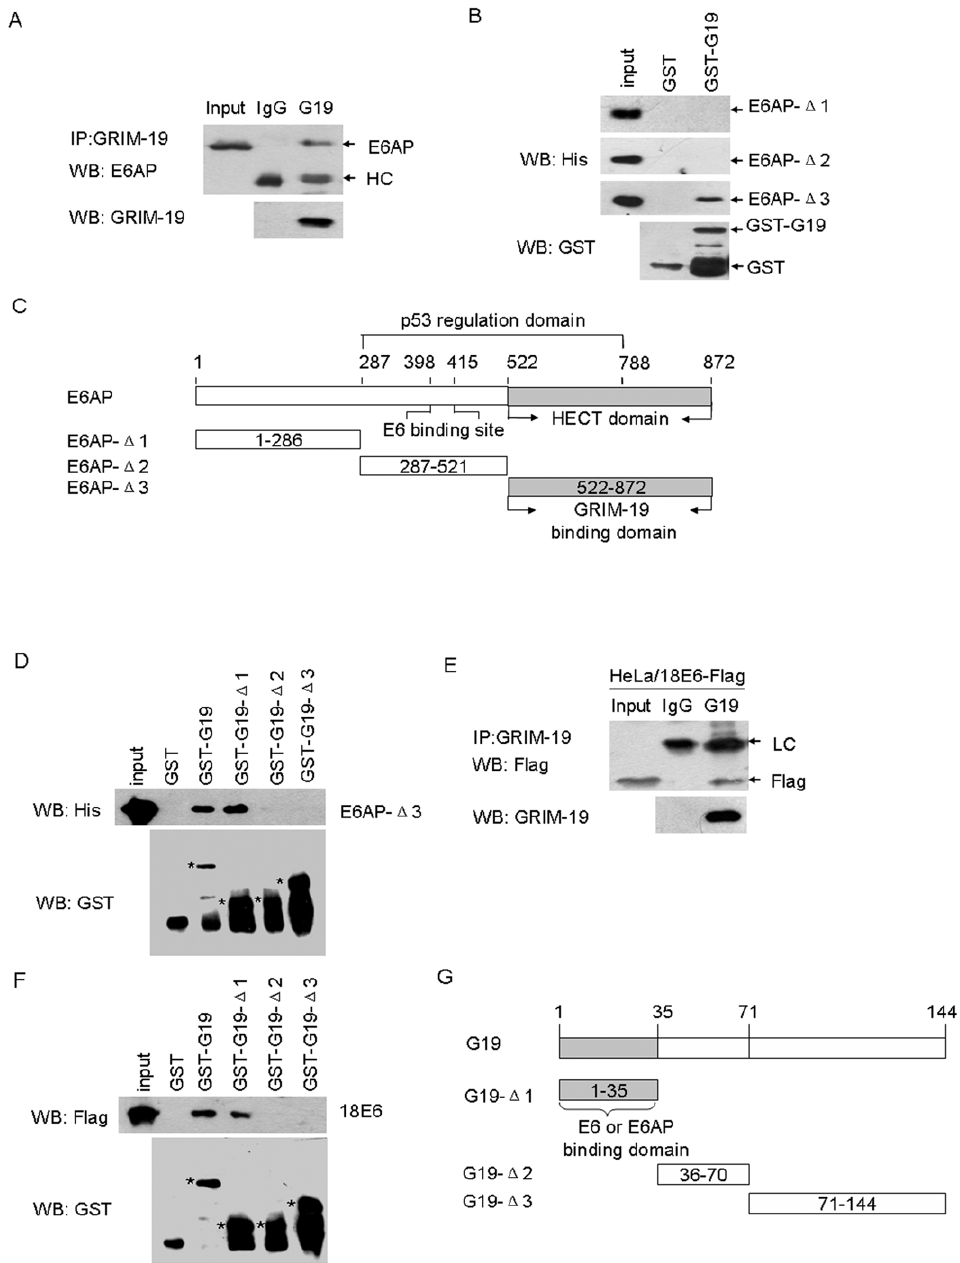
Figure 3. GRIM-19 bound to 18E6 and E6AP protein invivo and invitro . ( A ) Co-immunoprecipitation assays were performed to determine the interaction between GRIM-19 with E6AP in vivo . The cell lysates from HeLa cells were immunoprecipitated with normal IgG and anti-GRIM-19 antibodies and Western blotted with anti-E6AP. Input (preIP) lane represents 10% of the extract used in the immunoprecipitation reaction. HC=IgG heavy chain. ( B ) GST pull-down experiments were performed to examine the interaction of His-tagged E6AP deletions with GST-fused GRIM-19 protein in vitro . ( C ) Schematic diagram of E6AP indicating various functional domains including the binding sites for GRIM-19. ( D ) The interaction of GST-GRIM-19 deletions with E6AP. * indicates the position of the band with correct molecular size. ( E ) Co-immunoprecipitation assays were performed to determine the interaction between GRIM-19 with 18E6. The cell lysates from HeLa cells transfected with the p18E6-Flag were subjected to IP with the indicated antibodies. Input (preIP) lane represents 10% of the extract used in the immunoprecipitation reaction. LC=IgG light chain. ( F ) The interaction of GST-GRIM-19 deletions with 18E6. * indicates the position of the band with correct molecular size. ( G ) Deletion mapping of the E6 or E6AP binding sites on the GRIM-19. doi:10.1371/journal.pone.0022065.g003 head and neck squamous cell carcinomas, p53 status has been cancers [20]. Although such observations suggest a possibility that shown down regulate NF- k B and STAT3 induced gene expression loss of GRIM-19 promotes high STAT3 activity which could [44]. We have shown in our previous publication that GRIM-19 ultimately transcriptionally down regulate p53 expression, our studies did not reveal (fig. 2C &D) any changes in the expression of loss correlates with a high STAT3 activity in primary cervical